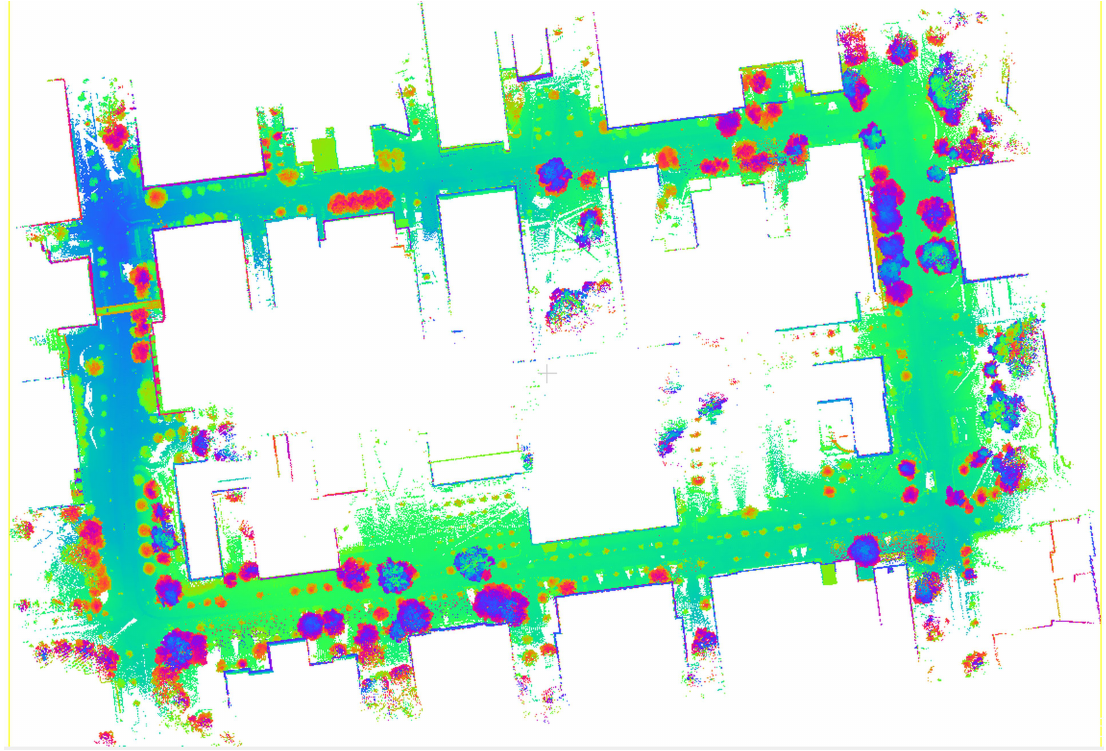
Figure 9. Three-dimensional point cloud generated by all LiDAR sensors.